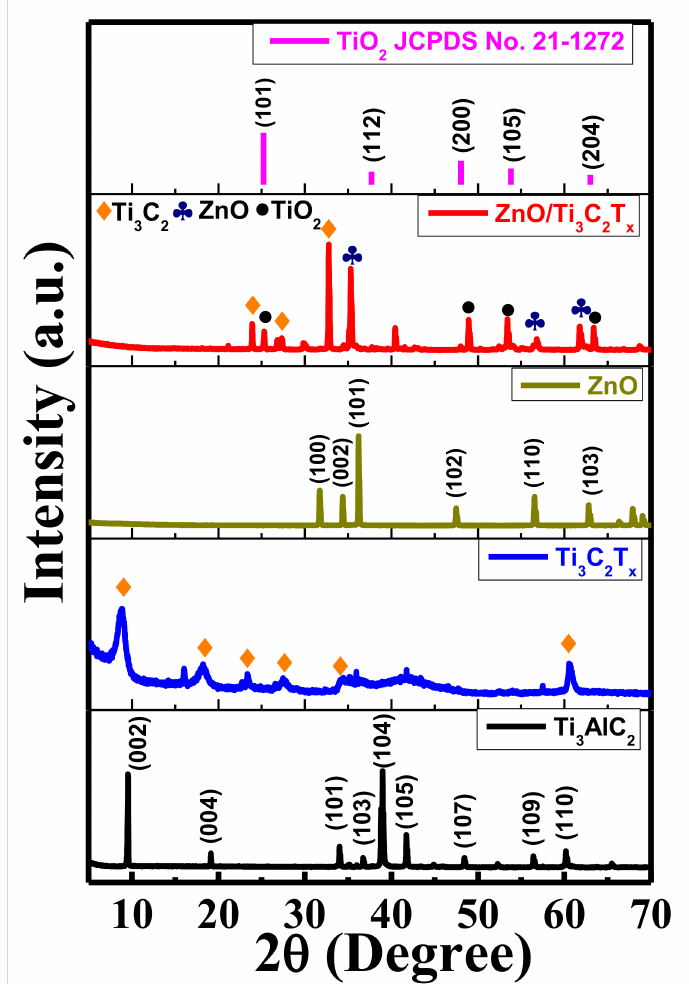
Figure 1. XRD patterns of the Ti 3 AlC 2 MAX phase, Ti 3 C 2 T x MXene, pure ZnO, and ZnO / Ti 3 C 2 T x hybrid